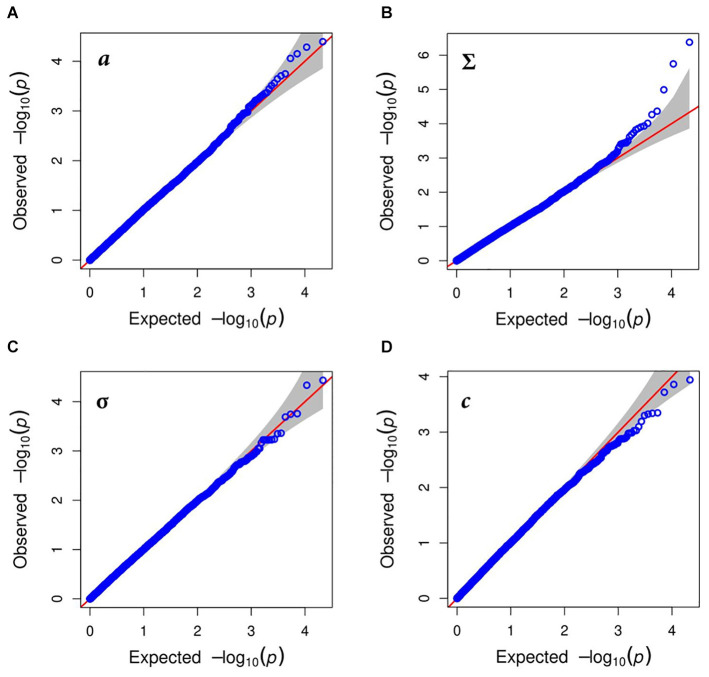
Quantile-quantile (QQ)-plots for biomass formation under water deficit condition traits after correction for population structure: (A) shows thermal leaf growth (a) of perennial ryegrass under optimal growth conditions; leaf growth reduction point (Σ) presented in (B); in (C) the leaf growth arrest point (σ) shown and tolerance to water deprivation (c) traits is given in (D).